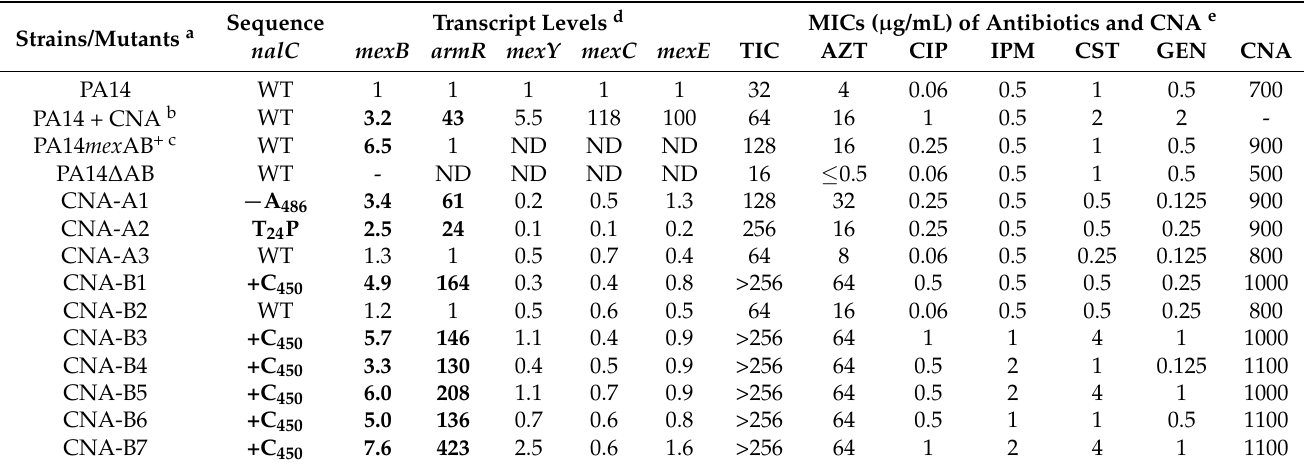
Table 1. Features of CNA resistant